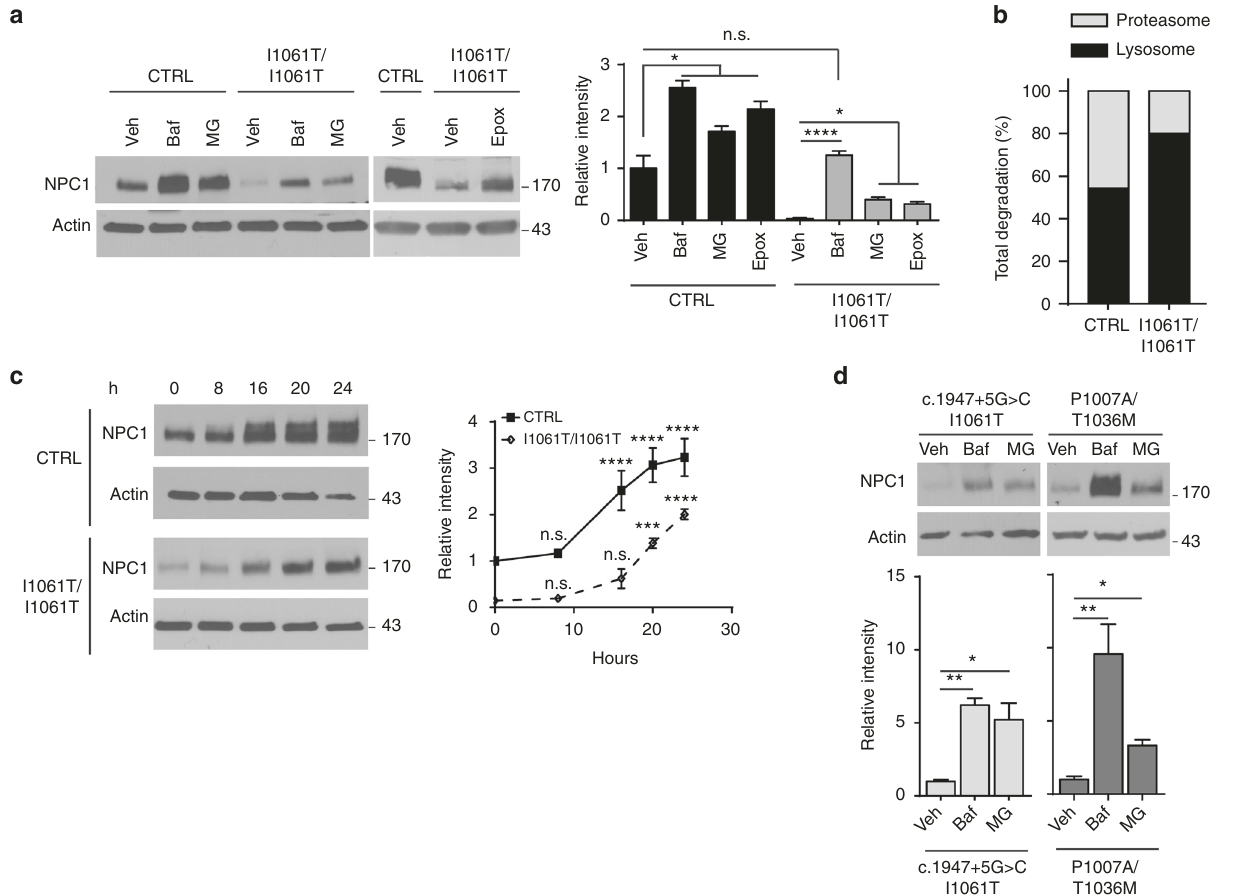
Fig. 1 I1061T NPC1 accumulates after lysosomal or proteasomal inhibition. a Primary human fi broblasts homozygous for WT NPC1 (CTRL) or I1061T NPC1 (I1061T) were treated with vehicle (Veh),100 nM ba fi lomycin A1 (Baf), 10 µ M MG132 (MG), or 100 nM epoxomicin (Epox) for 24 h. Quanti fi ed at right. b NPC1 protein levels quanti fi ed in a were normalized to calculate relative contribution of each pathway to NPC1 degradation. c Time course of NPC1 accumulation after treatment with Baf. Quanti fi ed at right. d Patient fi broblasts with the indicated NPC1 mutations were treated for 24 h with vehicle, 100 nM Baf, or 10 µ M MG. Normalized relative to CTRL and quanti fi ed below. a – d Data are mean ± s.e.m. from three independent experiments. n.s., not signi fi cant, * P ≤ 0.05, ** P ≤ 0.01, *** P ≤ 0.001, **** P ≤ 0.0001 by ANOVA with a – d Tukey ’ s or c Bonferroni posthoc test ( a F = 58.71; c F = 7.68; d F = (c.1947 + 5G>C/I1061T) 14.91, (P1007A/T1036M)